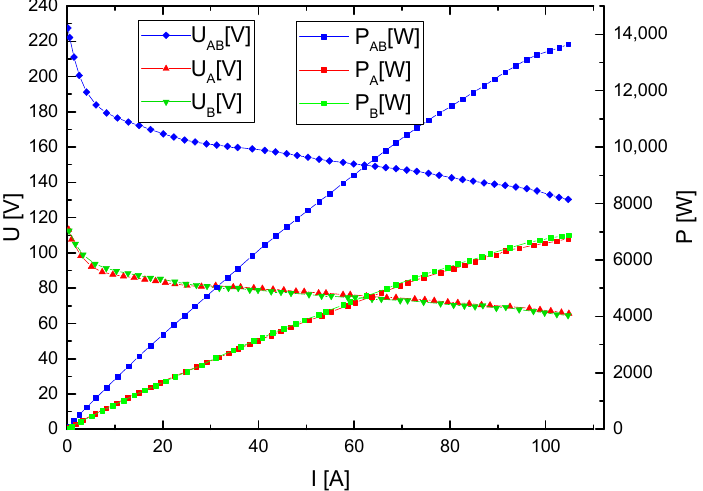
Figure 8. The U-I and P-I dependencies recorded for module (A) or (B) and after electrical series connections of both modules (A + B) .